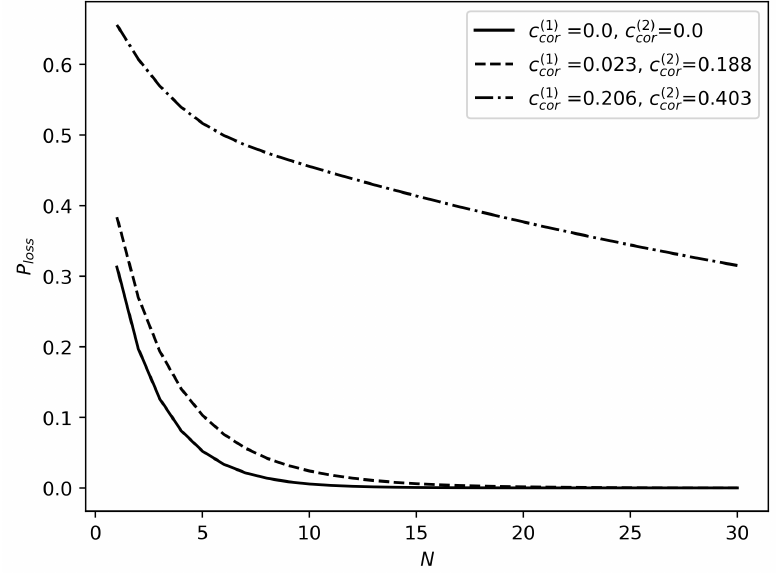
Figure 5. The loss probability P loss as a function of the buffer capacity N for BMMAP s with different coefficients of